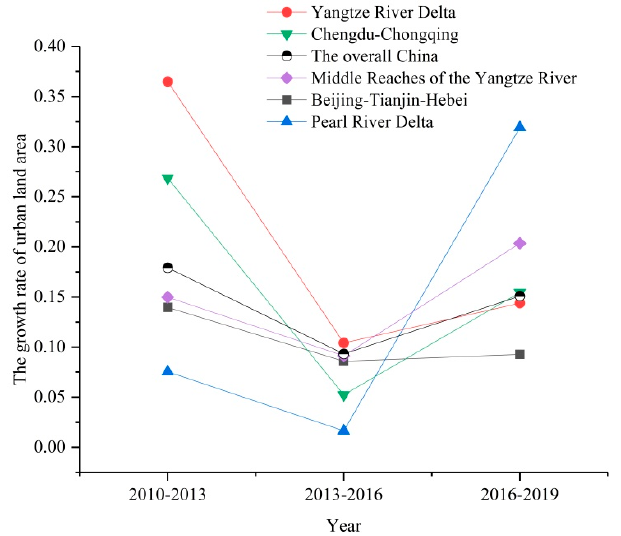
Figure 5. The growth rate of urban land area of overall China and five urban agglomerations in China.